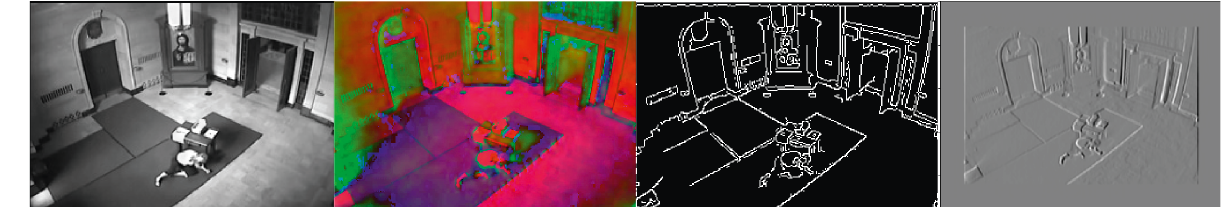
Figure 2: Sample image generated after applying feature extraction